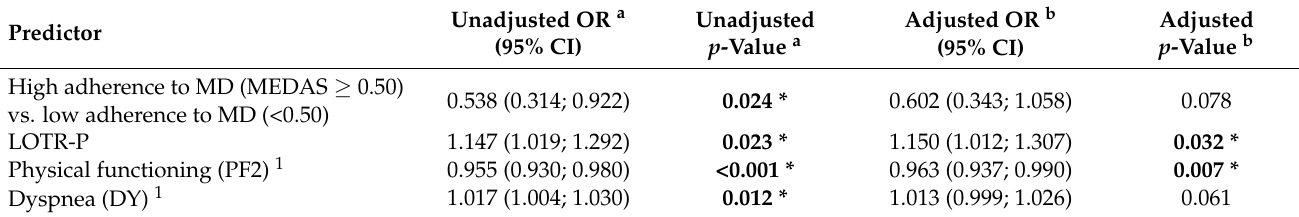
Table 4. Associations between MetS, lifestyle and HRQoL factors using logistic regression